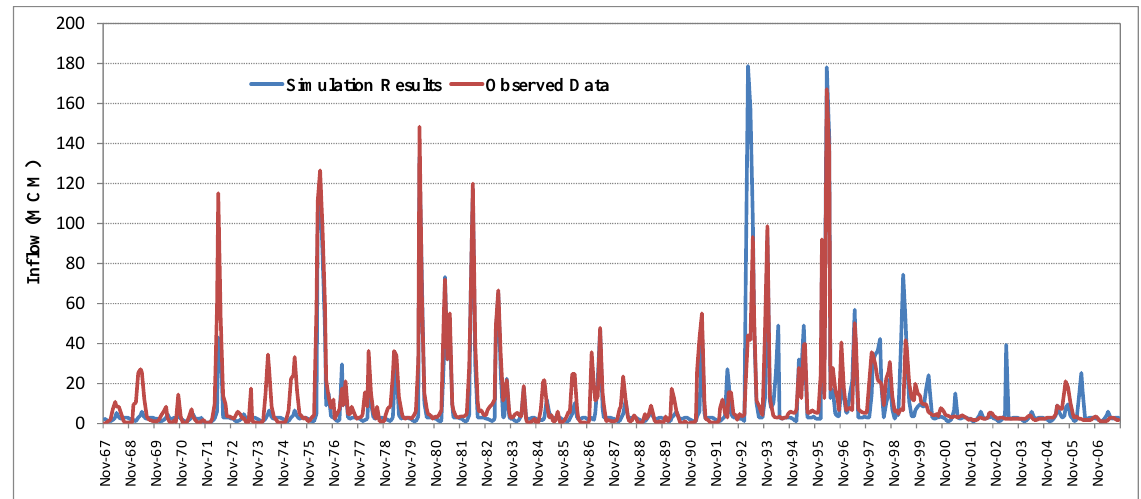
Figure 5. The calibration results of the water resources model in Safarzadeh station on Halil